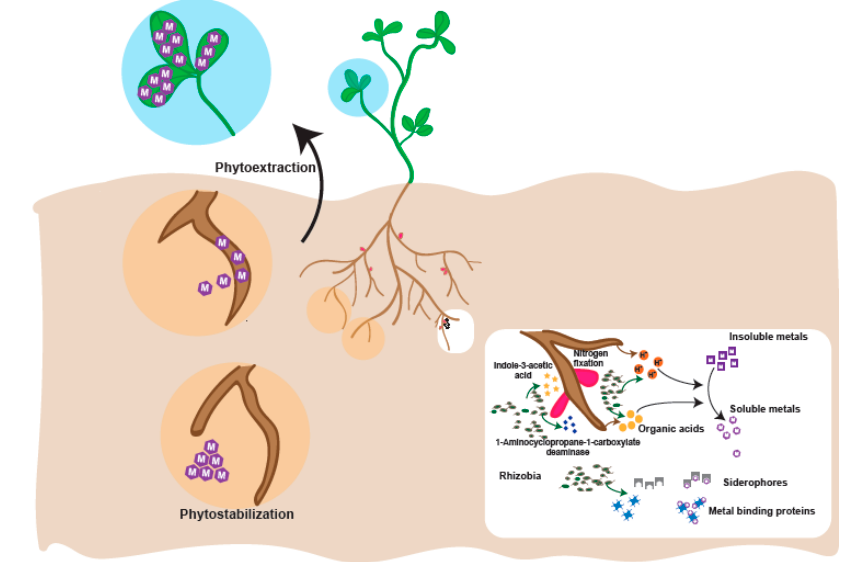
Figure 1. The mechanisms involved in bioremediation of heavy-metal contaminated soil and the contribution of PGP rhizobia.